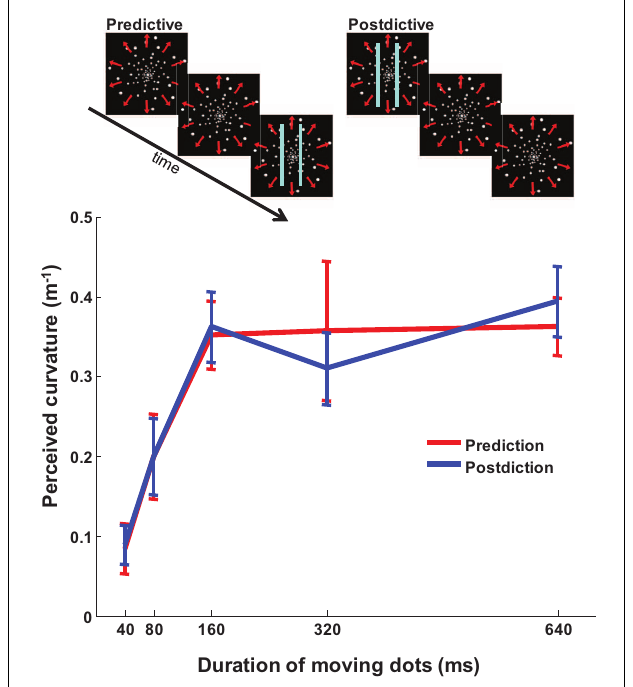
FIGURE 2 | Peri-dictive warping of the bars. The magnitude of the illusion is identical whether background motion precedes the presentation of the bars (prediction) or follows it (postdiction). Results reveal a window of motion integration between 80 and 160ms. In both conditions the bars flashed for 80ms; the optic flow pattern was followed by a blank screen for 1s, a noise grating for 4s, and another blank screen for 1s to eliminate motion after effect from one trial to the next. n = 8, error bars SEM.